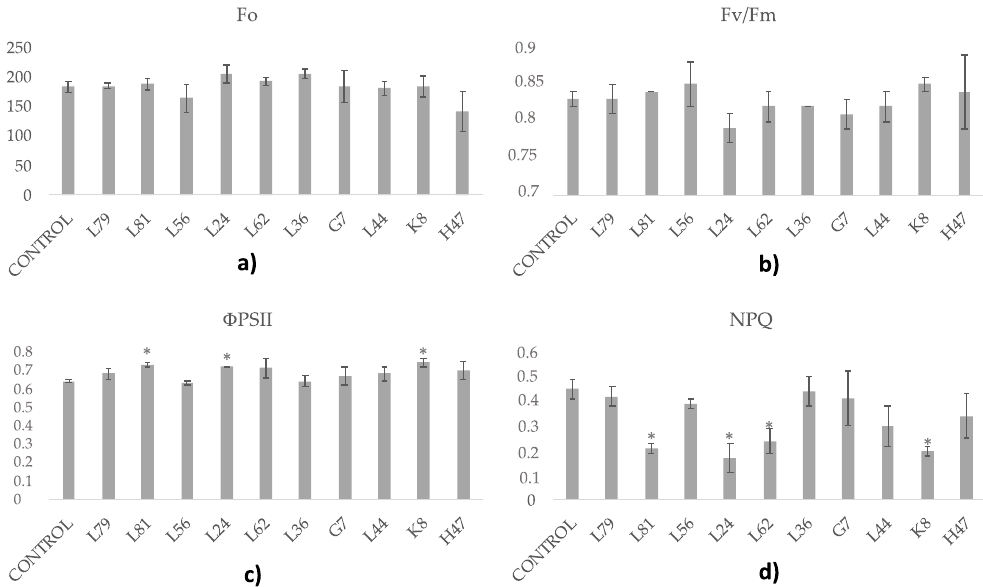
Figure 2. Photosynthetic parameters related to photosystems and light reactions. ( a ) Minimal fluorescence after 20-min dark-adaptation (Fo). ( b ) Maximal PSII quantum yield (Fv/Fm), ( c ) effective PSII quantum yield (ΦPSII) and ( d ) non-photochemical quenching coefficient (NPQ) measured in olive tree plants treated with the ten strains and the non-inoculated control. For each treatment and parameter average value ± standard error value ( n = 6) is presented. Asterisks (*) represent significant differences with the control according to the LSD test ( p < 0.05).